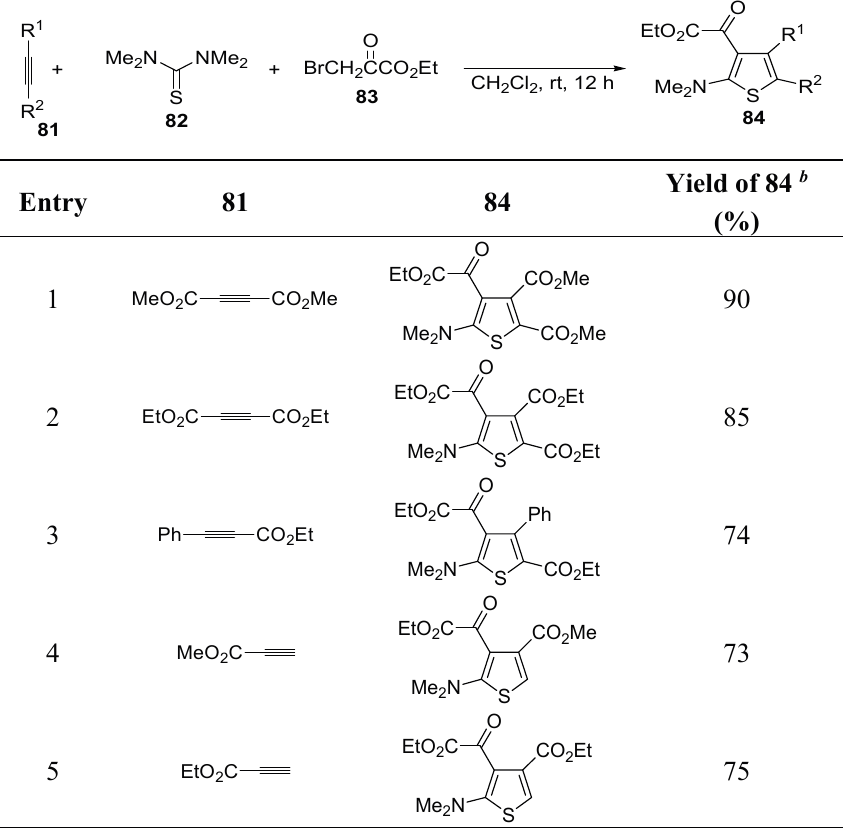
Table 8. Multicomponent synthesis of ethyl 2-(2-(dimethylamino)thiophen-3-yl)-2-oxoacetate derivatives 84 starting from acetylenic esters 81 , tetramethylthiourea 82 , and ethyl bromopyruvate 83 a